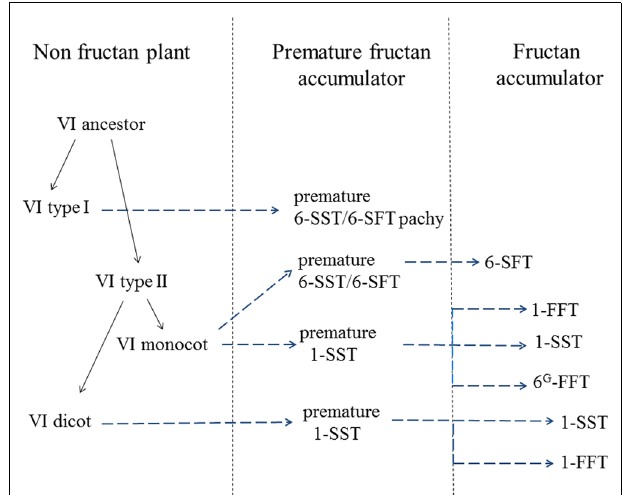
FIGURE 2 | Model depicting the putative evolution of different higher plant fructosyl transferases. Likely, an ancestralVI duplicated in twoVI types (I and II) in a non-fructan-accumulating plant, probably before the separation of monocots and dicots.Within the basal eudicots, a type IVI was recruited to create a preliminary FT (a 6-SST/6-SFT) in Pachysandra terminalis , a recent evolutionary event. During older evolutionary events, certain monocot and dicot type IIVIs evolved into preliminary 1-SSTs and 6-SST/6-SFTs that later specialized into genuine, more specific 1-SSTs and 6-SFTs. Likely, 1-FFTs (dicots) and 6G-FFTs (monocots) evolved later, based on (preliminary) 1-SST precursors. See text for more